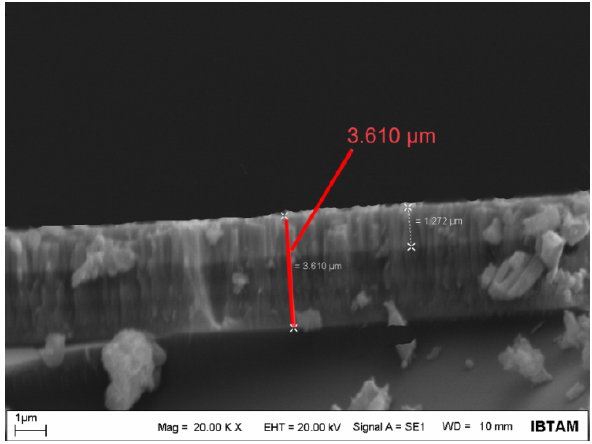
Figure 2: Cross section SEM image of C3